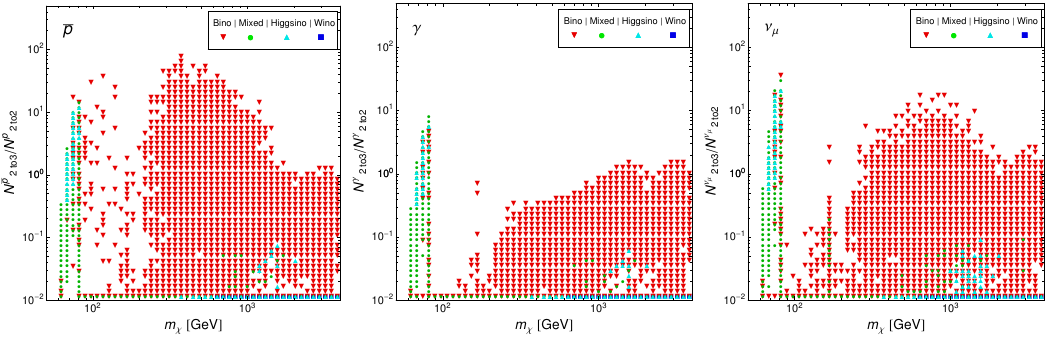
Figure 8 . Ratio of integrated yields above E X > m (cid:31) = 10 from (NWA-subtracted) three-body (cid:12)nal states and the two-body result, for species X = (cid:22) p; (cid:13); (cid:23) (cid:22) , plotted against the neutralino mass m (cid:31) . The other light lepton yields ( (cid:23) (cid:28) and e + ) are qualitatively very similar to the (cid:23) (cid:22) case. Di(cid:11)erent neutralino compositions are indicated as in (cid:12)gure 6.